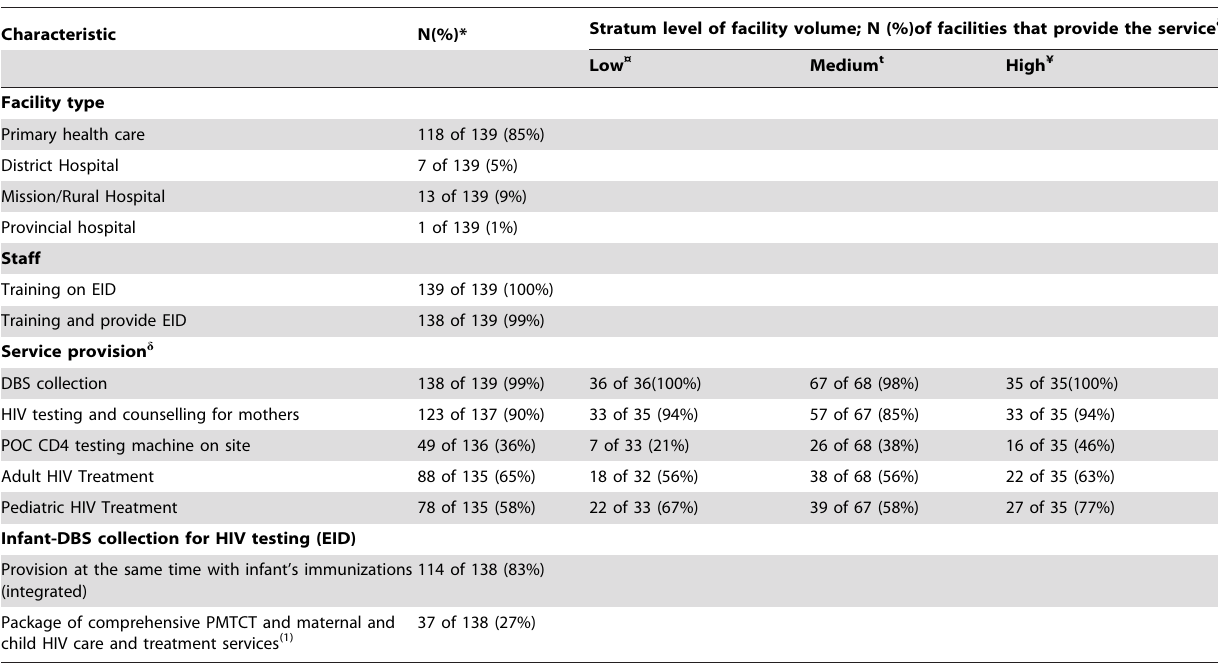
Table 1. Service provision model in integrating EID, PMTCT, HIV/AIDS care and treatment into MCH setting during post-delivery period in Zimbabwe, 2012 (N =139).